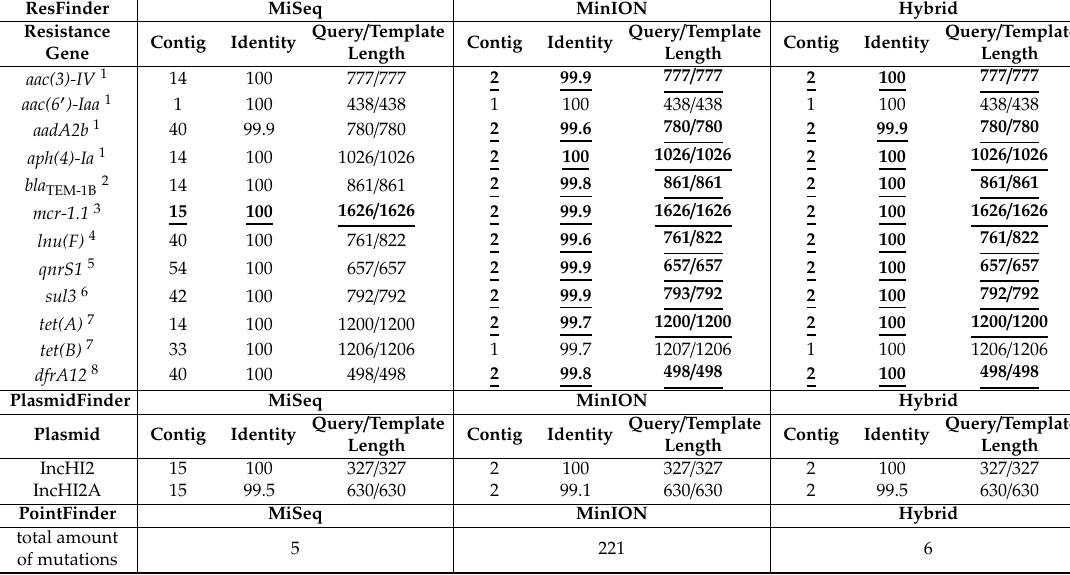
Table 3. Antimicrobial resistance genes, plasmid replicons and chromosomal mutations detected with ResFinder, PlasmidFinder and PointFinder in whole-genome MiSeq, MinION and hybrid assembly of Salmonella isolate S15BD05371 extracted with the Genomic Tip 100.